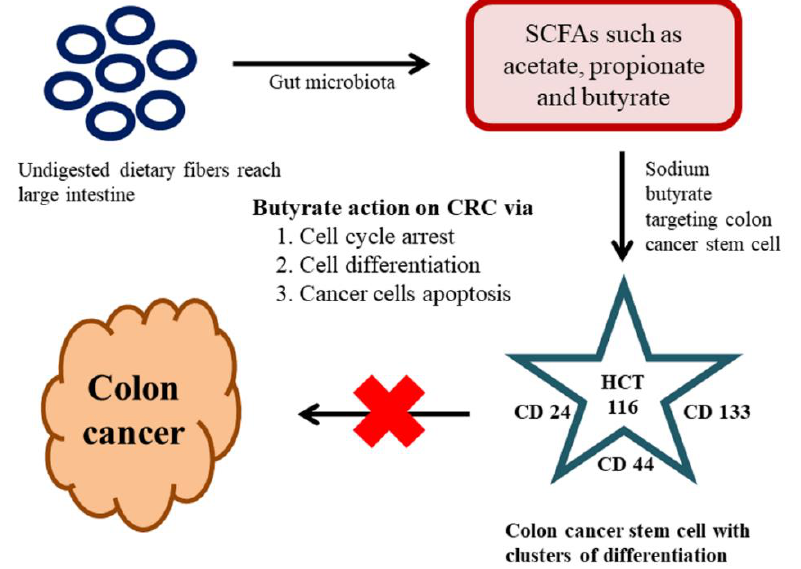
Figure 3. Effect of the gut microbiome on colon cancer stemm cells (CSCs) and colorectal cancer (CRC).